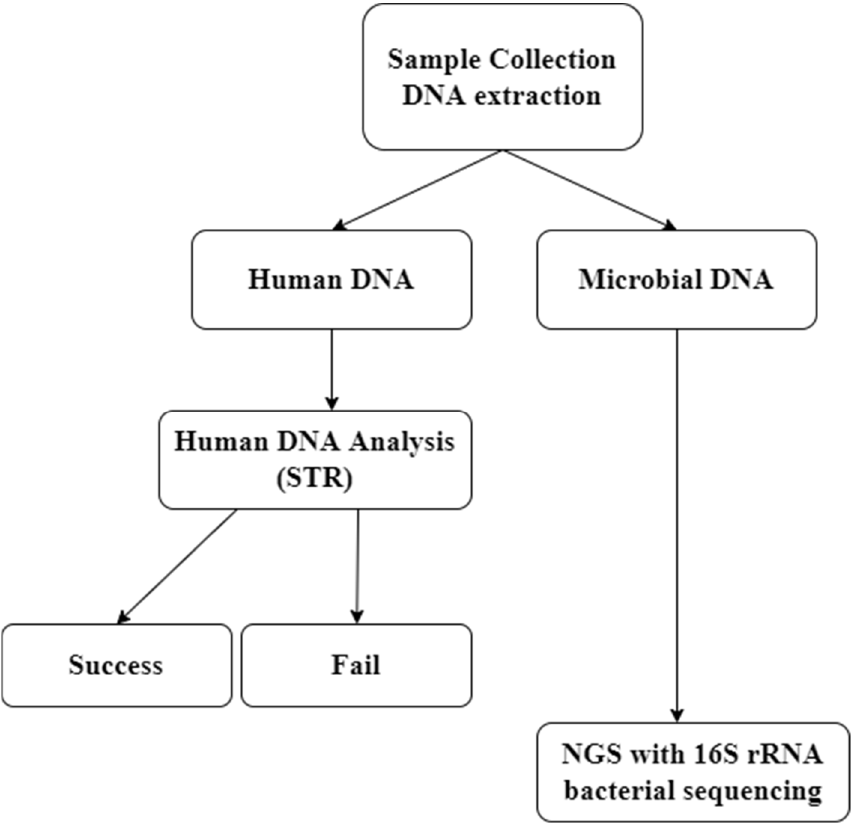
Figure 1. Schematic of the application of Bacterial profiling. Human DNA analysis and microbial DNA analysis are possible simultaneously through one DNA extraction.